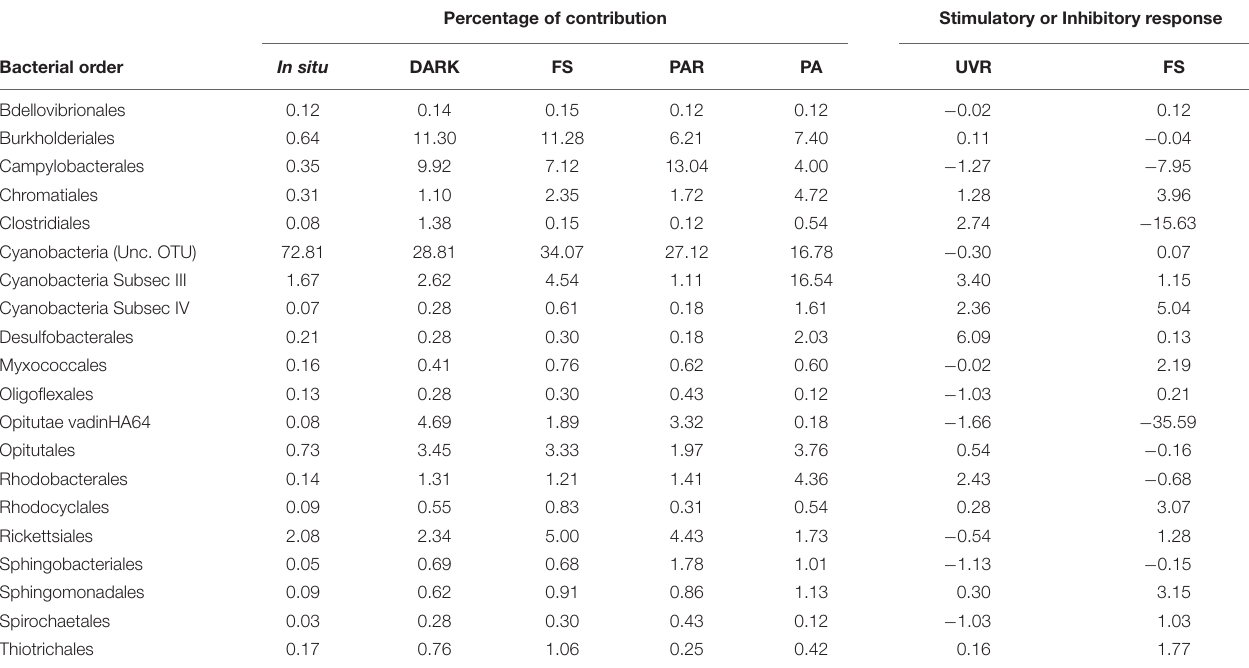
TABLE 2 | Characterizing the response of bacterial orders present (percentages) in situ and in all the different treatments and their response to UVR and FS, in terms of whether they were stimulated (positive values) or inhibited (negative values) under experimental treatments at hours of high irradiation (11:30